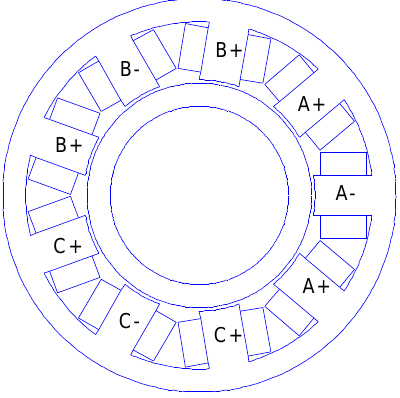
Figure 3. Nine-pole 3-phase bearing with a [A, − A,A,B, − B,B,C, − C,C]